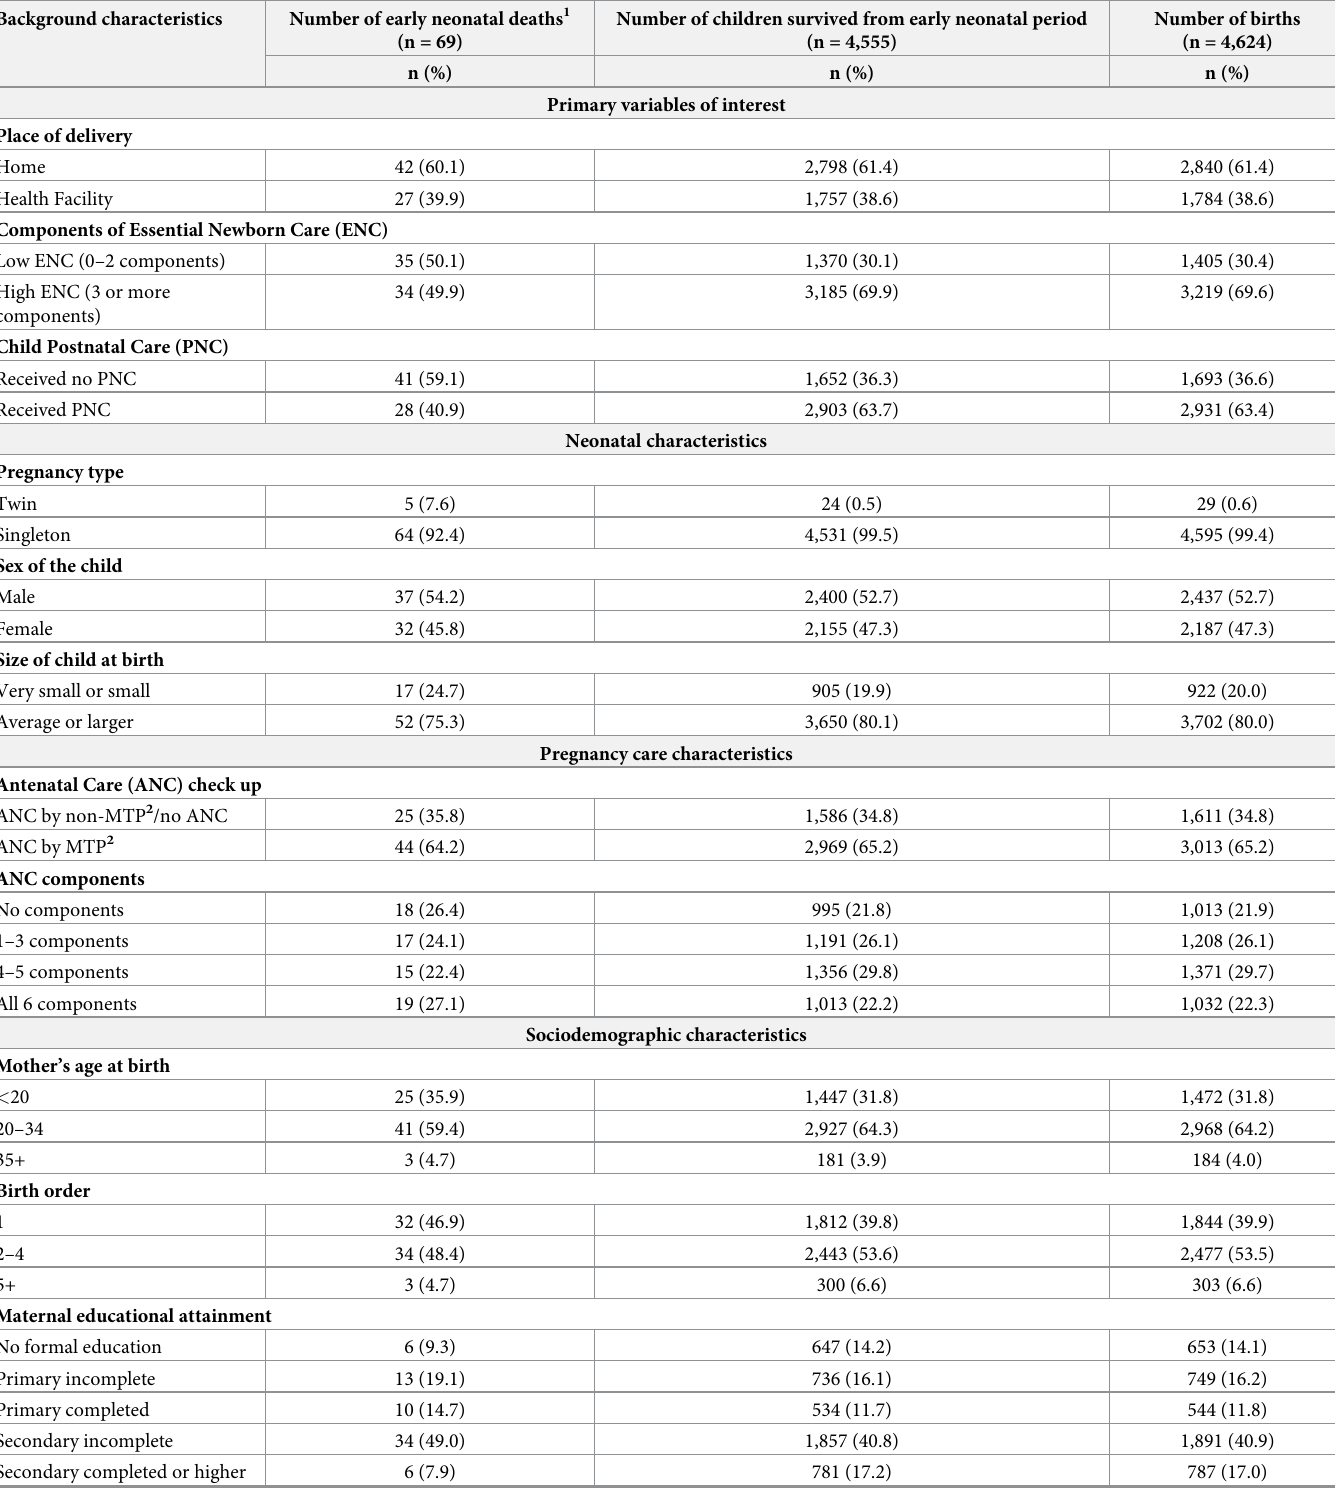
Table 1. Distribution of most recent live births in the three years before the survey by background characteristics and neonatal survival status, Bangladesh DHS 2014. Background